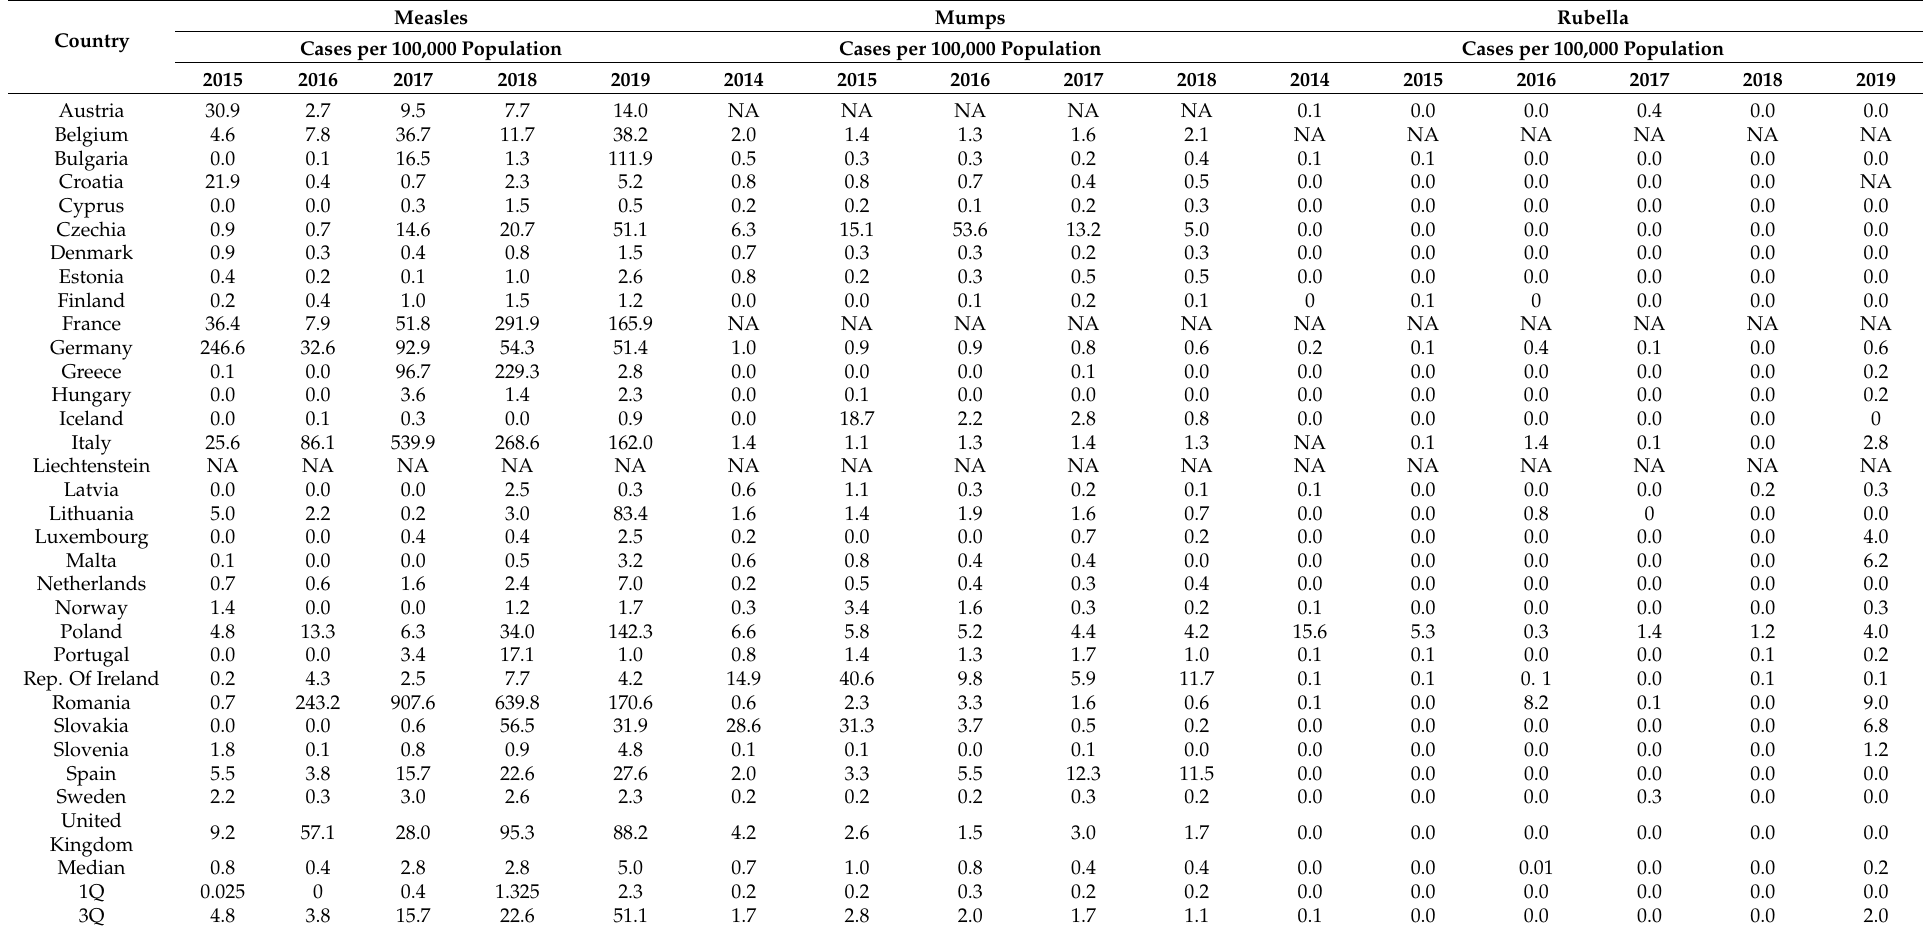
Table 1. Incidence of measles, mumps, and rubella in the EU and EFTA countries in selected years. Measles Mumps Country